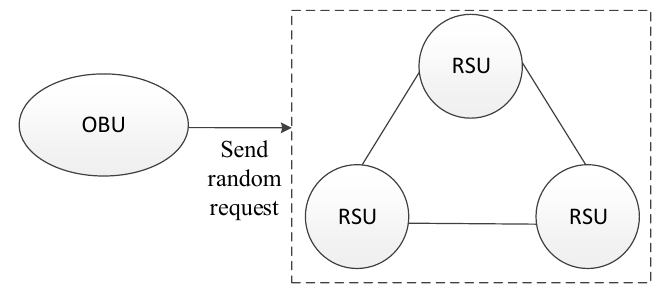
Figure 6. Network topology.